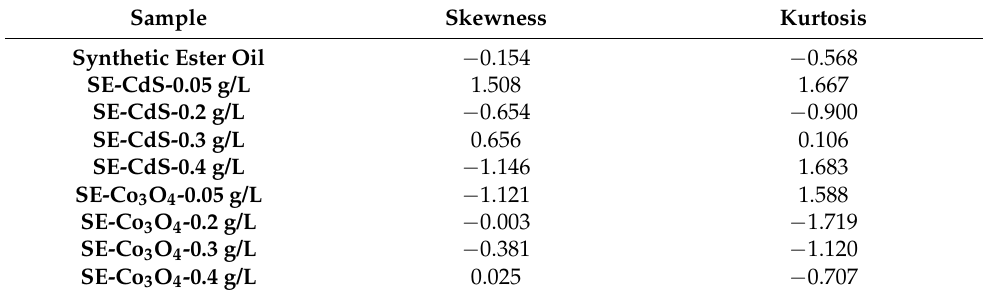
Table 5. Skewness and kurtosis of the AC breakdown voltage of synthetic ester and nanofluids.